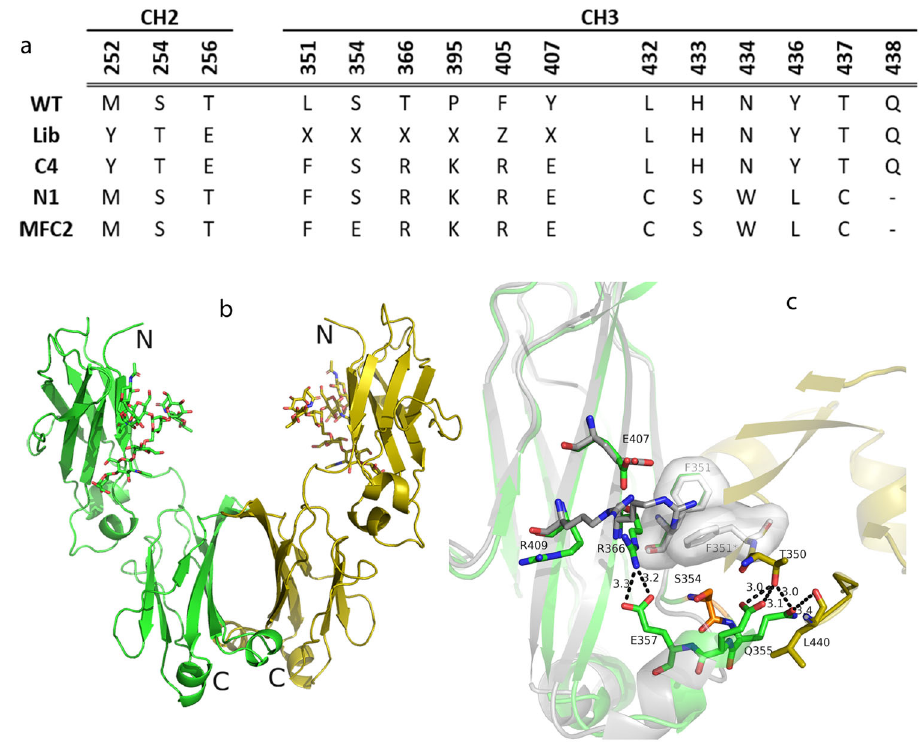
Fig. 1 Structure-guided rational design for next-generation monomeric Fc designs. a Sequence alignment of CH2 and CH3 domains in wild-type IgG4, MFc1, and MFc2 from a previous phage library campaign, T1 variant, which replaces the YTE mutations in the MFc1 CH2 domain with a CH3 mutation set, and fi nal sequences of MFc3 and MFc4. b Crystal structure of T1. c A closer look revealed a small set of hydrogen bonds formed in Thr350/Leu440 and Gln355/Glu356 between the crystallographic dimer chains, indicating that a possible breach of the monomeric Fc formation for T1 remained under the crystallographic conditions. The hydrogen bonds involved in the IgG4 CH3 dimer interface are now absent in the T1 crystallographic dimer due to the introduced monomer-stabilizing mutations in MFc2 (Fig. S1). Table 1 Crystallographic data and re fi nement